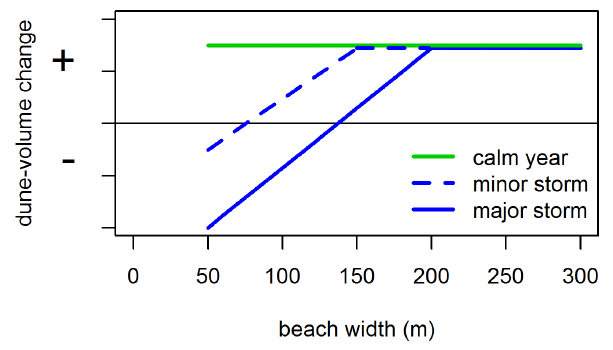
Figure 12. Schematic illustration of the influence of storminess and beach width on foredune volume. When beach widths are less than 200 m, D V depends on storminess. When beach width is over 200 m, as occurs e.g. on Terschelling and Schiermonnikoog, D V is no longer dependent on storminess or beach width.